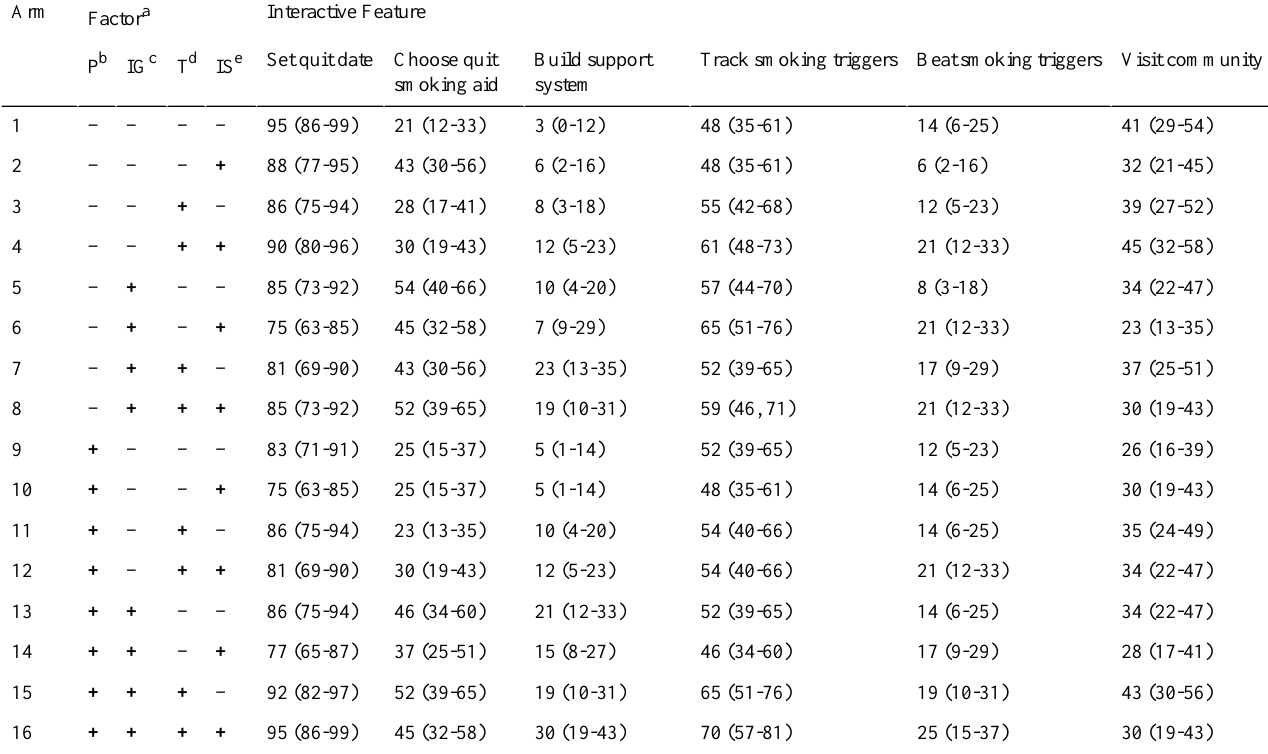
Table 3. Arm-specific interactive feature utilization rates (95% CI).